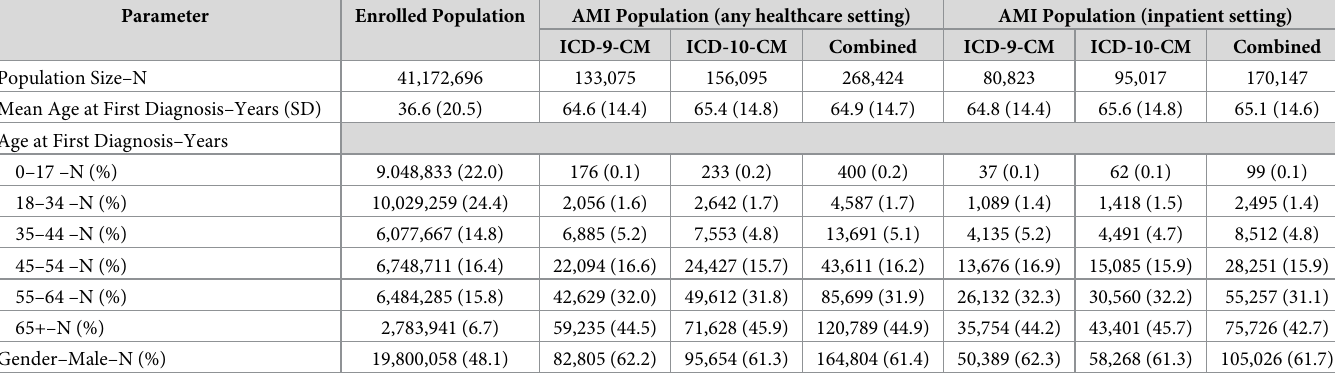
� Abbreviations: AMI, acute myocardial infarction; ICD-CM, International Classification of Diseases, Clinical Modification; N, number. There were 33,216,843 individuals enrolled for at least one calendar year between 2014–2015 (ICD-9-CM era) and 30,319,401 individuals enrolled for at least one calendar year between 2015– 2017 (ICD-10-CM